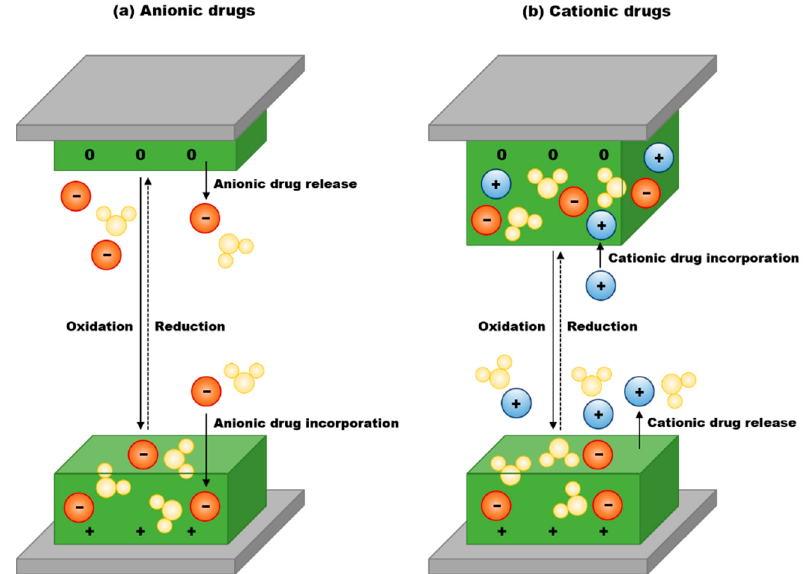
Figure 9. Release of anionic drugs occurs by anion driven shrinking when a CP is oxidized ( a ) whereas cationic drugs are released during reduction of a CP by cation drive ( b ).